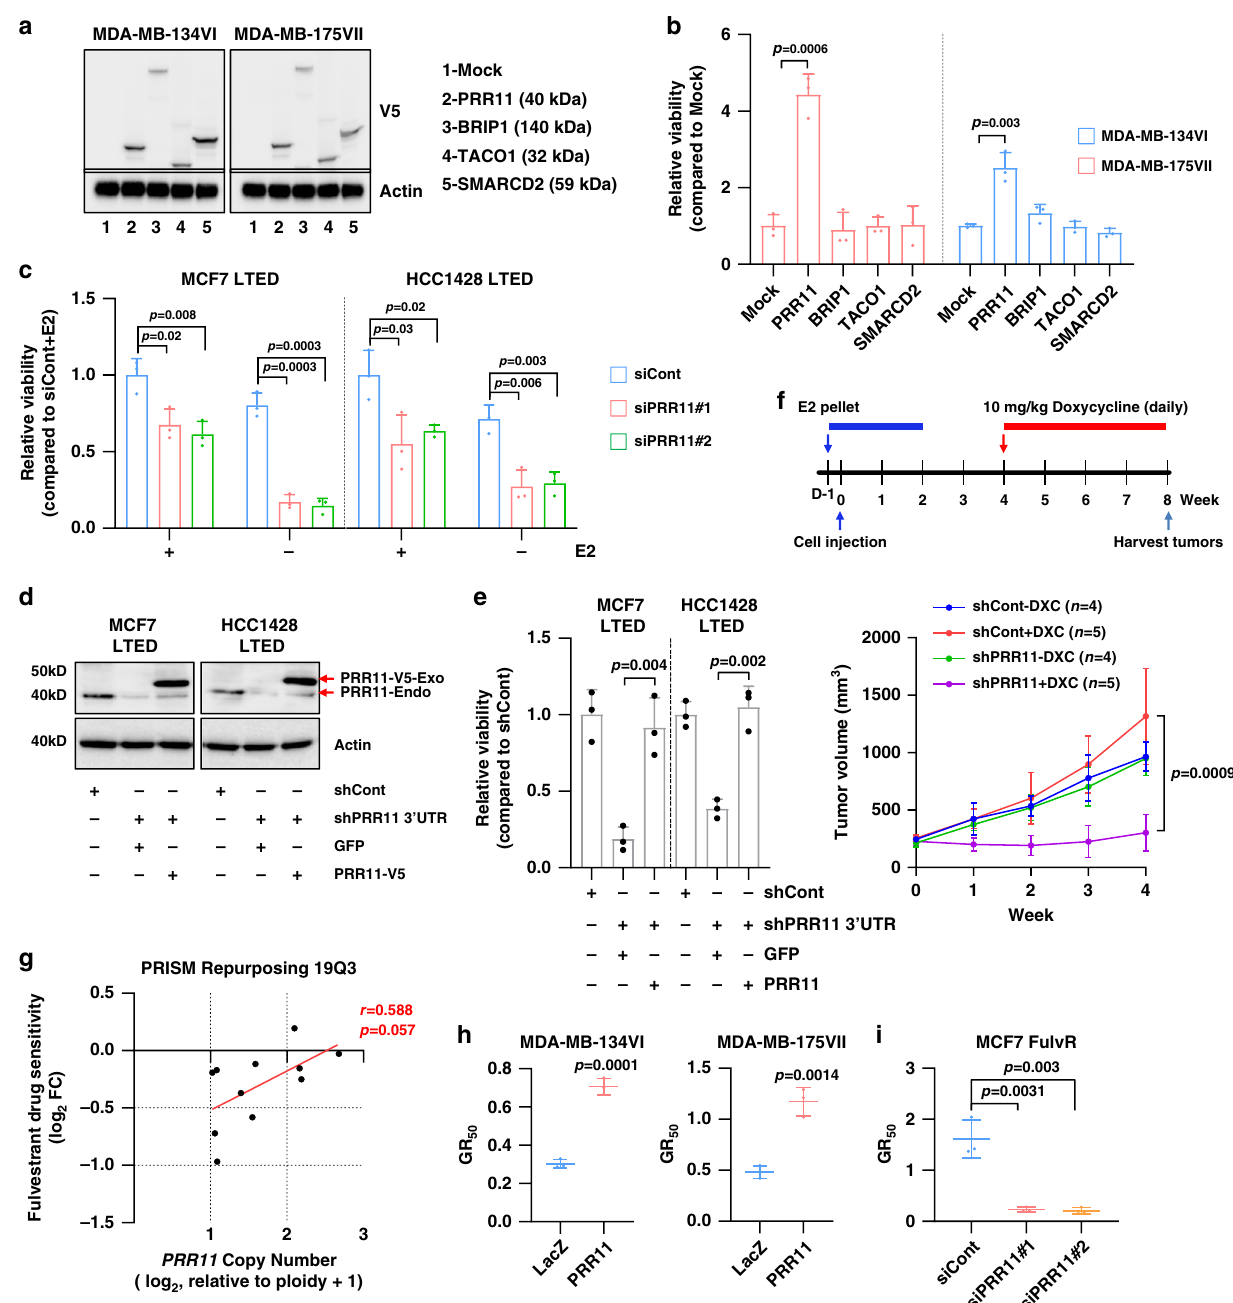
Fig. 3 PRR11 overexpression confers resistance to antiestrogens. a Lysates of MDA-MB-134VI and MDA-MB-175VII cells that had been transduced with pLX304- PRR11 , - BRIP1 , - TACO1 , and - SMARCD2 were subjected to immunoblot analysis. b Low density monolayers of MDA-MB-134VI and MDA-MB-175VII pLX304- PRR11 , - BRIP1 , - TACO1 , and - SMARCD2 cells were grown in estrogen-deprived condition. After 2 weeks, cell monolayers were stained with crystal violet and cell viability quanti fi ed as described in Methods. Data represent the mean±SD of three replicates (two-tailed unpaired t -tests). c MCF7 LTED and HCC1428 LTED cells were transfected with PRR11 siRNAs. Low density monolayers of cells were treated±1nM estrogen (E2) for 10 days. Cell monolayers were stained with crystal violet. Data represent the mean±SD of three replicates (two-tailed unpaired t -tests). d , e MCF7 LTED and HCC1428 LTED cells were transduced with shRNA targeting the 3 ′ UTR of PRR11 and then, re-transduced with pLX304- GFP or pLX304- PRR11 . Cell lysates were subjected to immunoblot analysis ( d ). Upper and lower arrows indicate exogenous and endogenous PRR11, respectively. Low density monolayers of cells shown in d were grown in absence of E2 for 10 days ( e ). Data represent the mean±SD of three replicates (two-tailed unpaired t -tests). f MCF7 cells stably expressing doxycycline-inducible- PRR11 shRNA and control shRNA were injected s.c. in the dorsum of athymic ovariectomized mice supplemented with a 14-day release 17 β -estradiol pellet. After 4 weeks, mice were randomized to treatment with 10mg/kg doxycycline (i.p) for 4 weeks. Each data point represents the mean tumor volume in mm 3 ±SD; n of mice per group are shown in parenthesis (two-tailed unpaired t -tests). g Fulvestrant sensitivity of ER + breast cancer cell lines ( n = 11, PRISM Repurposing 19Q3 dataset). Y -axis, drug sensitivity, represents relative barcode abundance following fulvestrant treatment (Pearson correlation). h , i Fulvestrant GR 50 were calculated using the GR metrics calculator 56 (http://www.grcalculator.org/grcalculator/). Cell numbers on days 0 and 6 were used as the input data. MDA-MB-134VI and MDA-MB-175VII cells were stably transduced with pLX302- LacZ (control) or pLX302- PRR11 ( h ). MCF7 FulvR cells were transfected with control or PRR11 siRNA ( i ). Data represent the mean±SD of three replicates (two-tailed unpaired t -tests). Source data are provided as a Source data fi